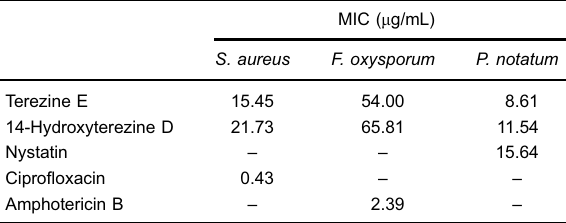
Table 1. Minimum inhibitory concentration (MIC) values of the antifungal and antibacterial activities of terezine E and 14- hydroxyterezine D against Staphylococcus aureus, Fusarium oxysporum , and Penicillium notatum using nystatin, cipro fl oxacin, and amphotericin B as positive